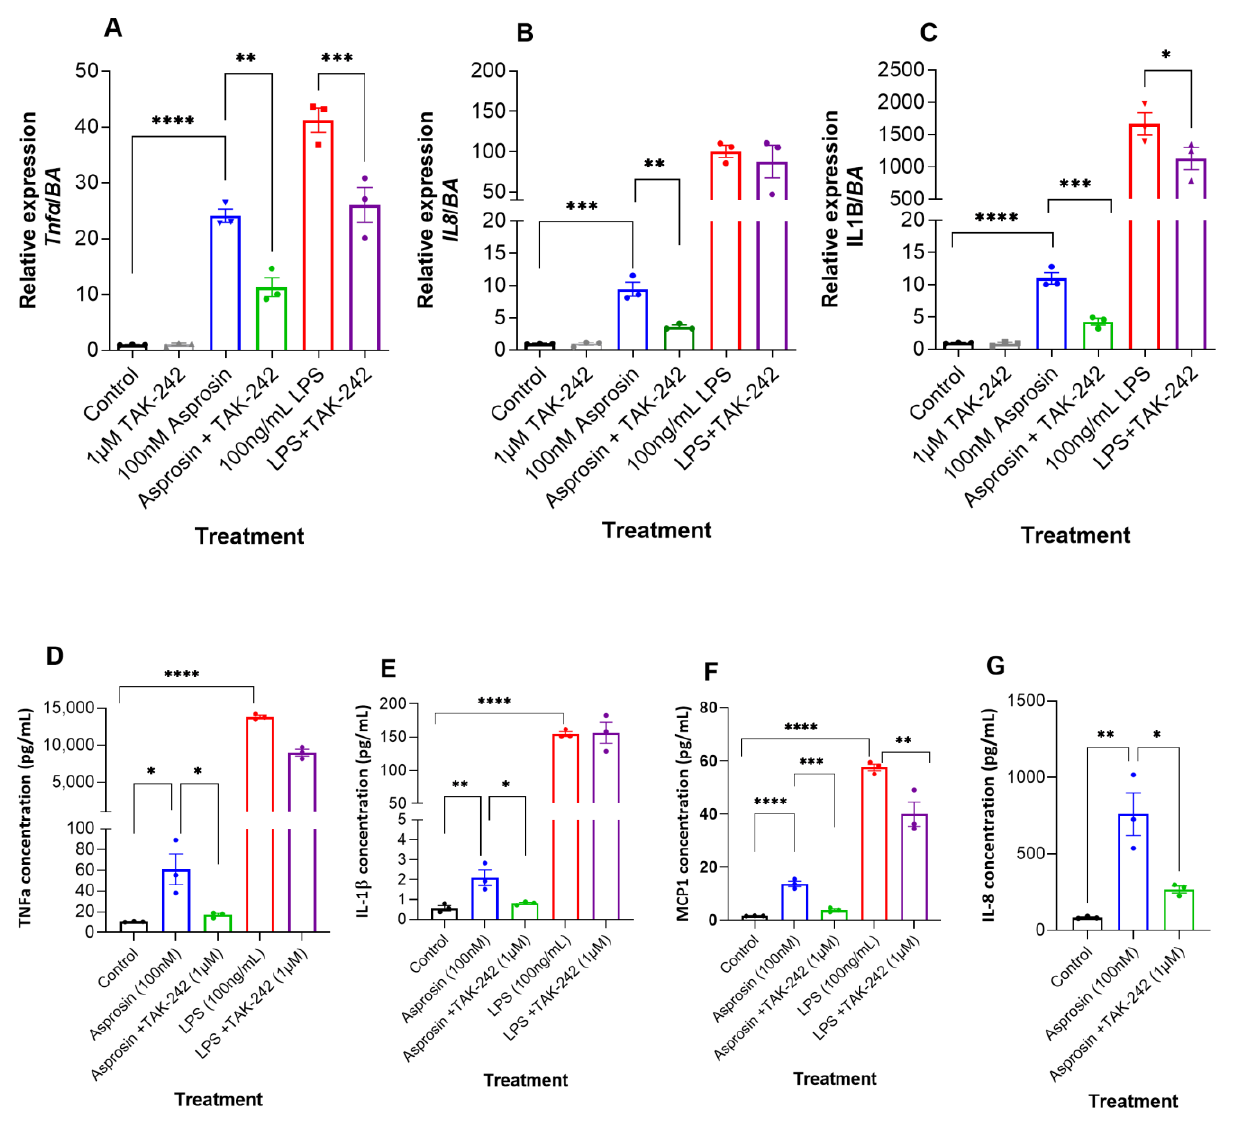
Figure 5. Asprosin-induced inflammation in THP-1 macrophages is inhibited by TAK-242, a Toll-like receptor 4 (TLR4) inhibitor. ( A ) Tumour necrosis factor α (TNF α ); ( B ) Interleukin-1 β (IL-1 β ); and ( C ) IL-8 mRNA levels were measured by qRT PCR in THP-1 macrophages treated with 1 µ M TAK-242 for 1 h, prior to 4 h stimulation with 100 nM asprosin or 100 ng/mL lipopolysaccharide (LPS). Data are presented as fold-change (mean ± SEM) in transcript. The experiments were repeated in three independent cultures. One-way ANOVA; * p < 0.05; ** p < 0.01; *** p < 0.001; **** p < 0.0001. Secreted levels of TNF α ( D ), IL-1 β ( E ), MCP-1 ( F ) and IL-8 ( G ) were measured by a human cytokine BioPlex array in cell supernatant of THP-1 macrophages treated with 1 µ M TAK-242 for 1 h, prior to 4 h stimulation with 100 nM asprosin or 100 ng/mL LPS. The experiments were repeated in three independent cultures. One-way ANOVA; * p < 0.05; ** p < 0.01; *** p < 0.001; **** p < 0.0001.